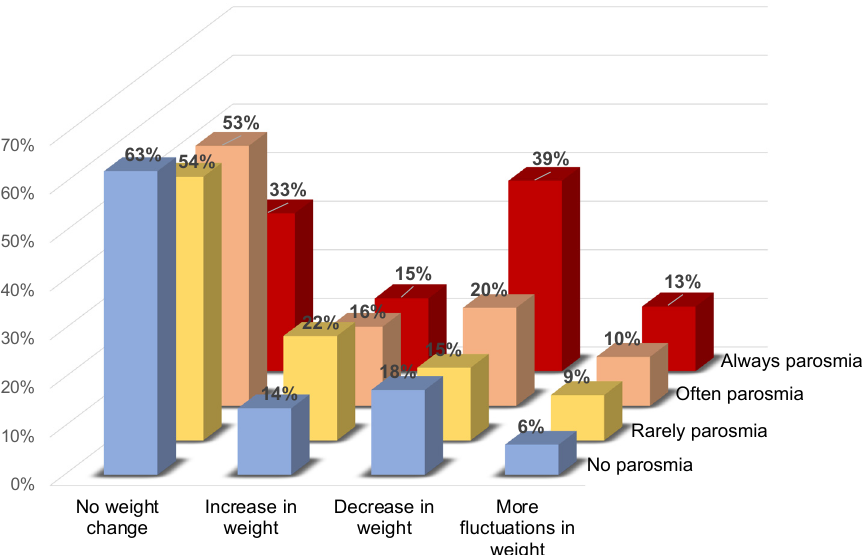
Figure 2. Weight change in parosmia. The incidence of weight changes is compared between participants with no parosmia (blue), rarely parosmia (yellow), often parosmia (orange), and always parosmia (red). Higher severity of parosmia is associated with a higher incidence of weight loss, more fluctuations in weight, and less stabile weight (no weight change).